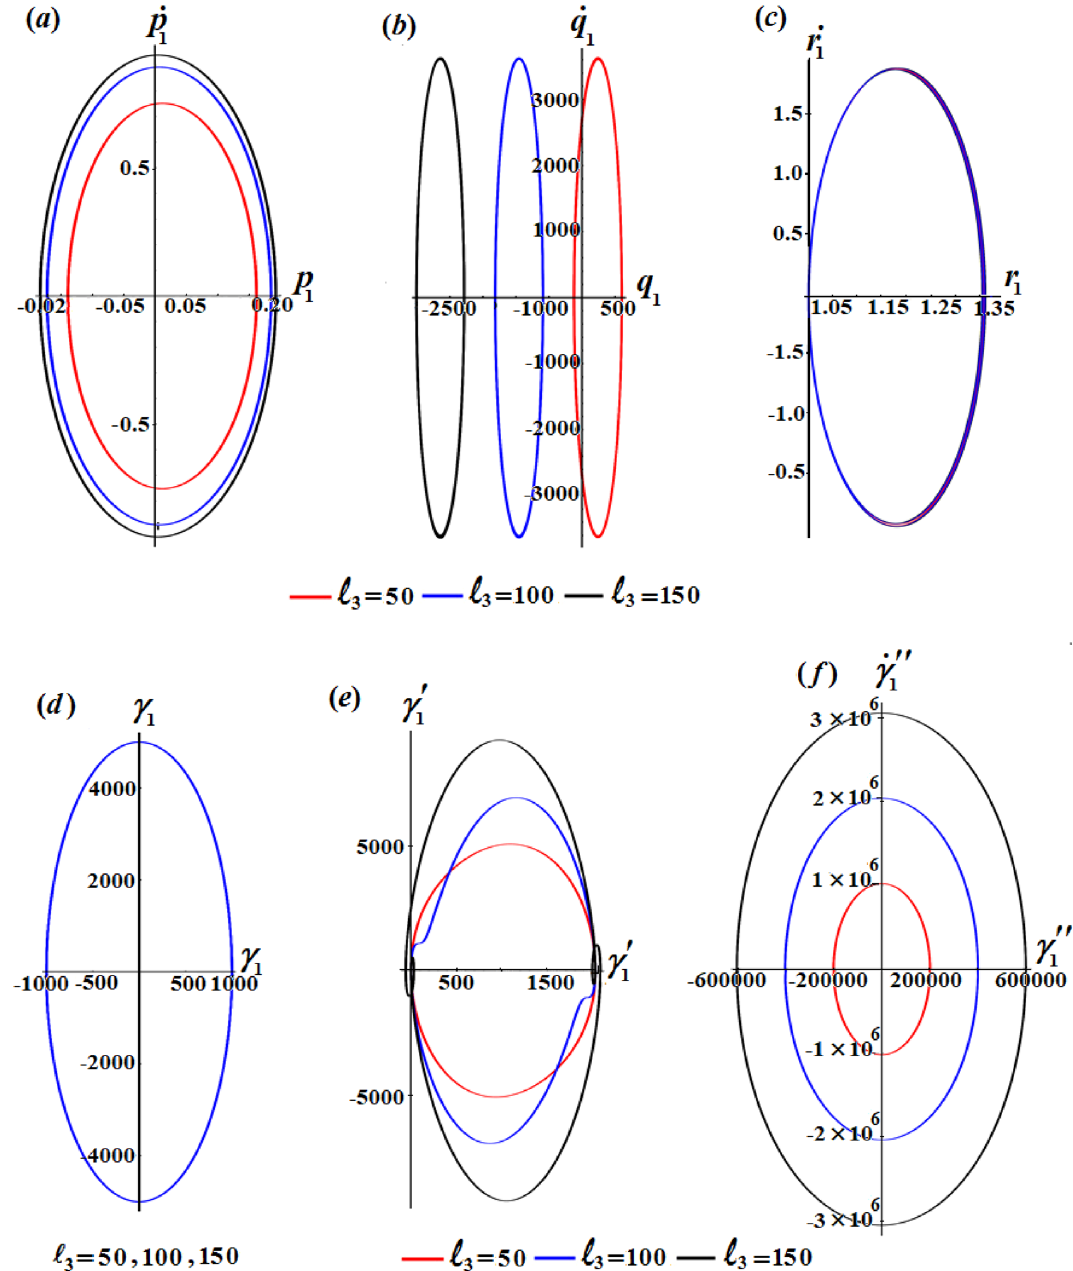
50, 100, 150 ) kg m 2 s − 1 =